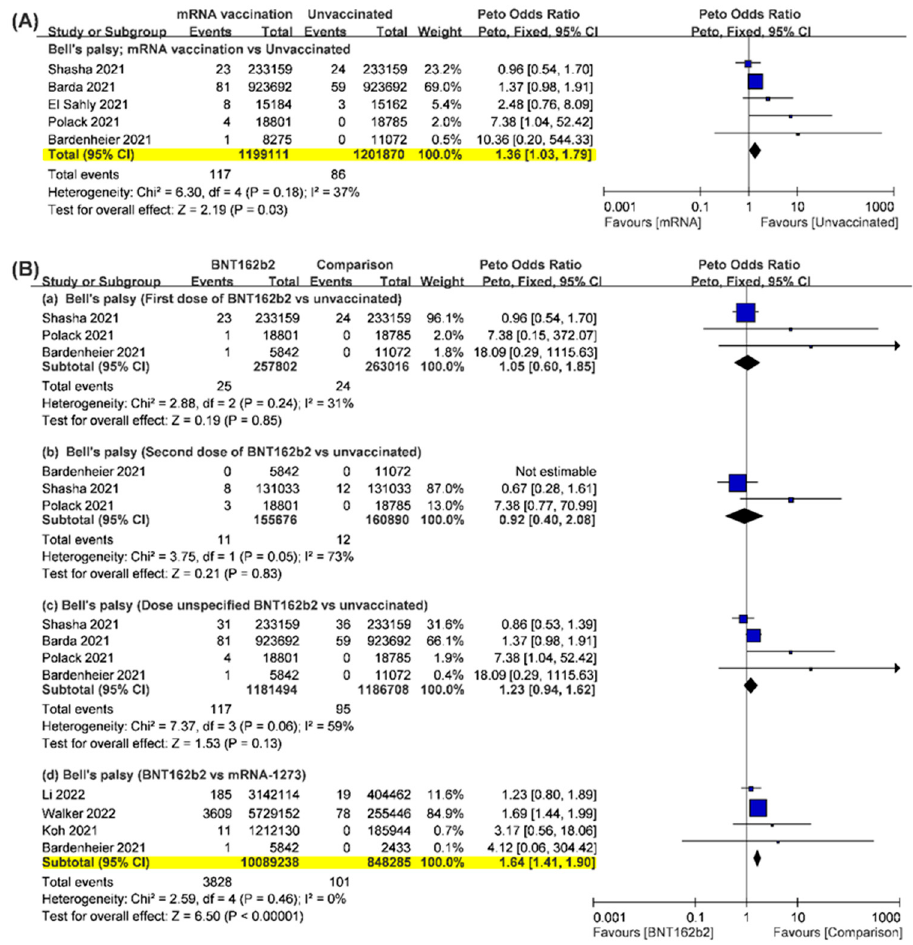
Figure 2. Forest plot analysis of the incidence of Bell’s palsy after the administrations of mRNA vaccines versus the unvaccinated group ( A ) and BNT162b2 vaccines versus other comparisons ( B ). Statistical significance is highlighted in yellow.